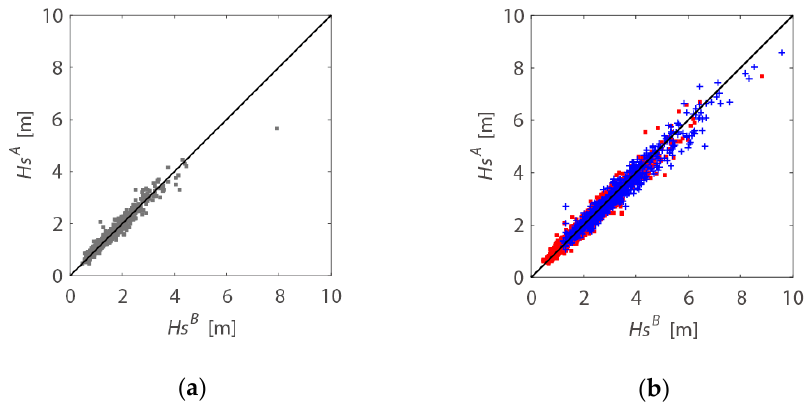
Figure 4. Buoy H B s and altimeter H A s when the wind speed is lower ( a ) or higher ( b ) than 5 m · s − 1 . In the right-hand panel, the blue (red) plots indicate data for the case in which the wind speed is higher (lower) than 10 m · s − 1 .